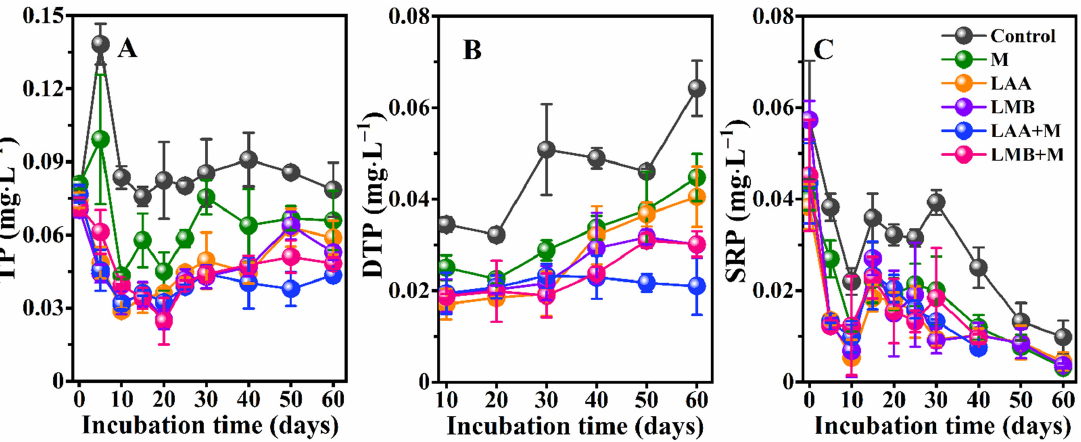
Figure 1. The changes of TP, DTP, and SRP concentrations in the overlying water of the six treatments during the experiment. Vertical bars indicate standard deviation. ( A – C ) represent TP, DTP, and SRP in the overlying water, respectively.